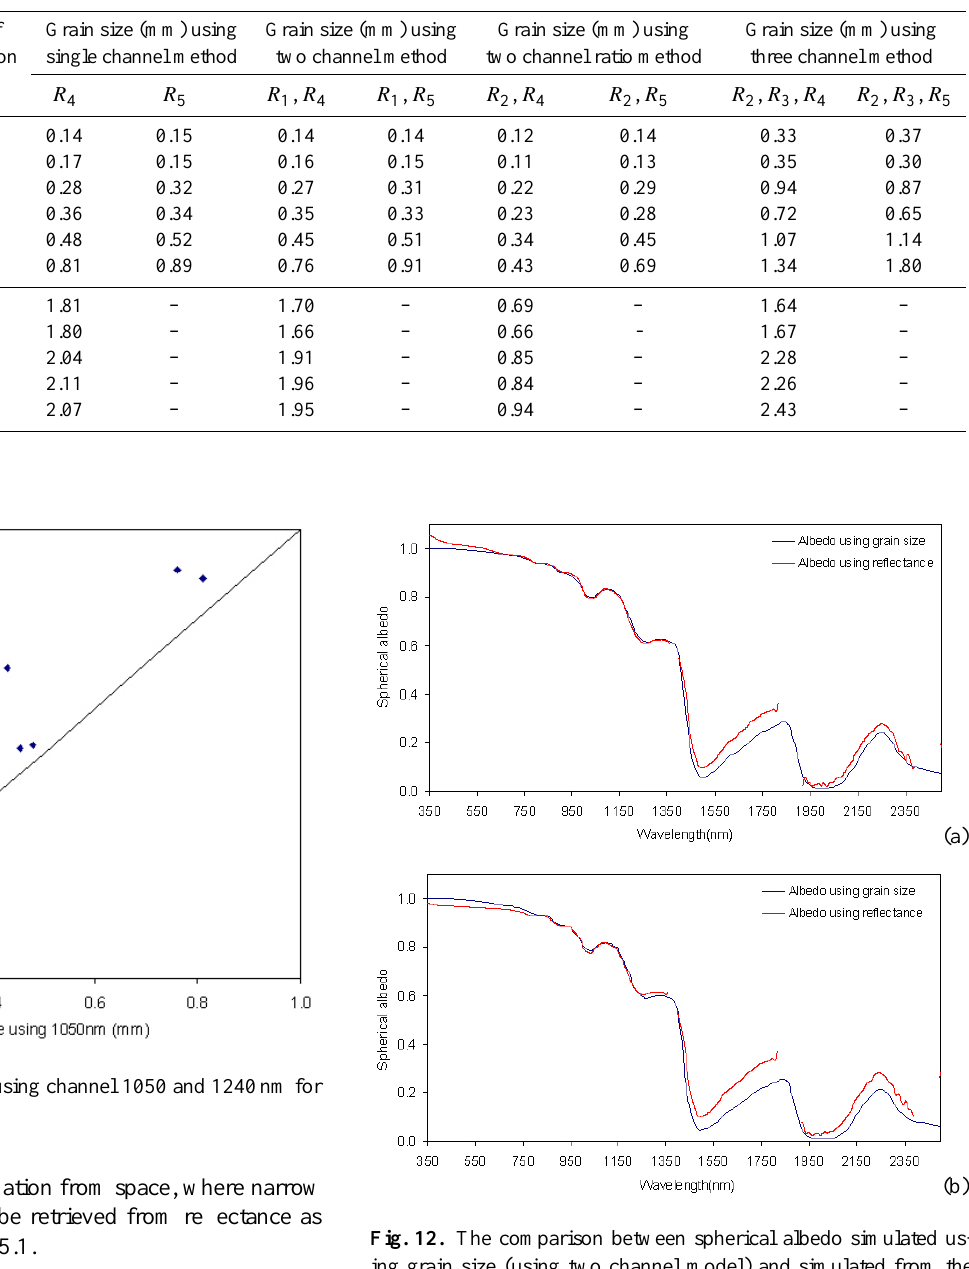
Table 2. Retrieved snow grain size “ d ” (i.e., 2 × a ef ) using single channel method, two channel method, two channel ratio method and three